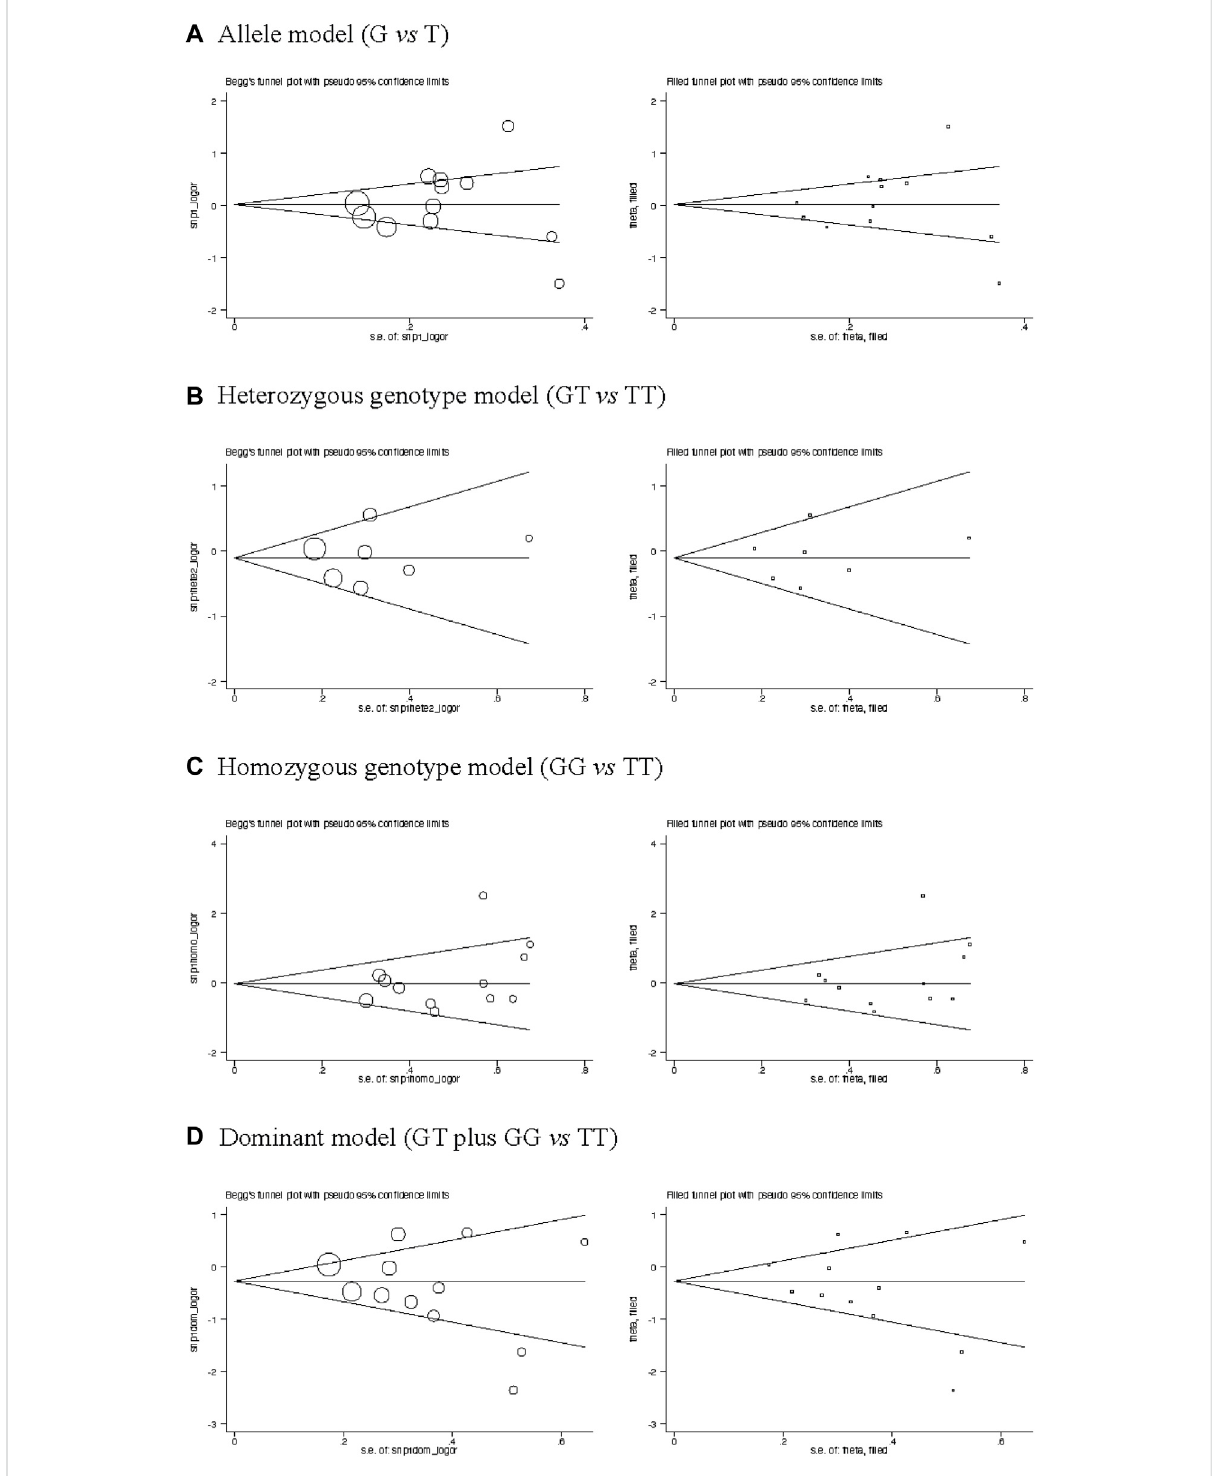
FIGURE 3 Funnel plots of VDBP gene rs7041 polymorphism with COPD under four models of inheritance. (A) Allele model (G vs. T), (B) Heterozygous genotype model (GT vs. TT), (C) Homozygous genotype model (GG vs. TT), (D) Dominant model (GT plus GG vs.